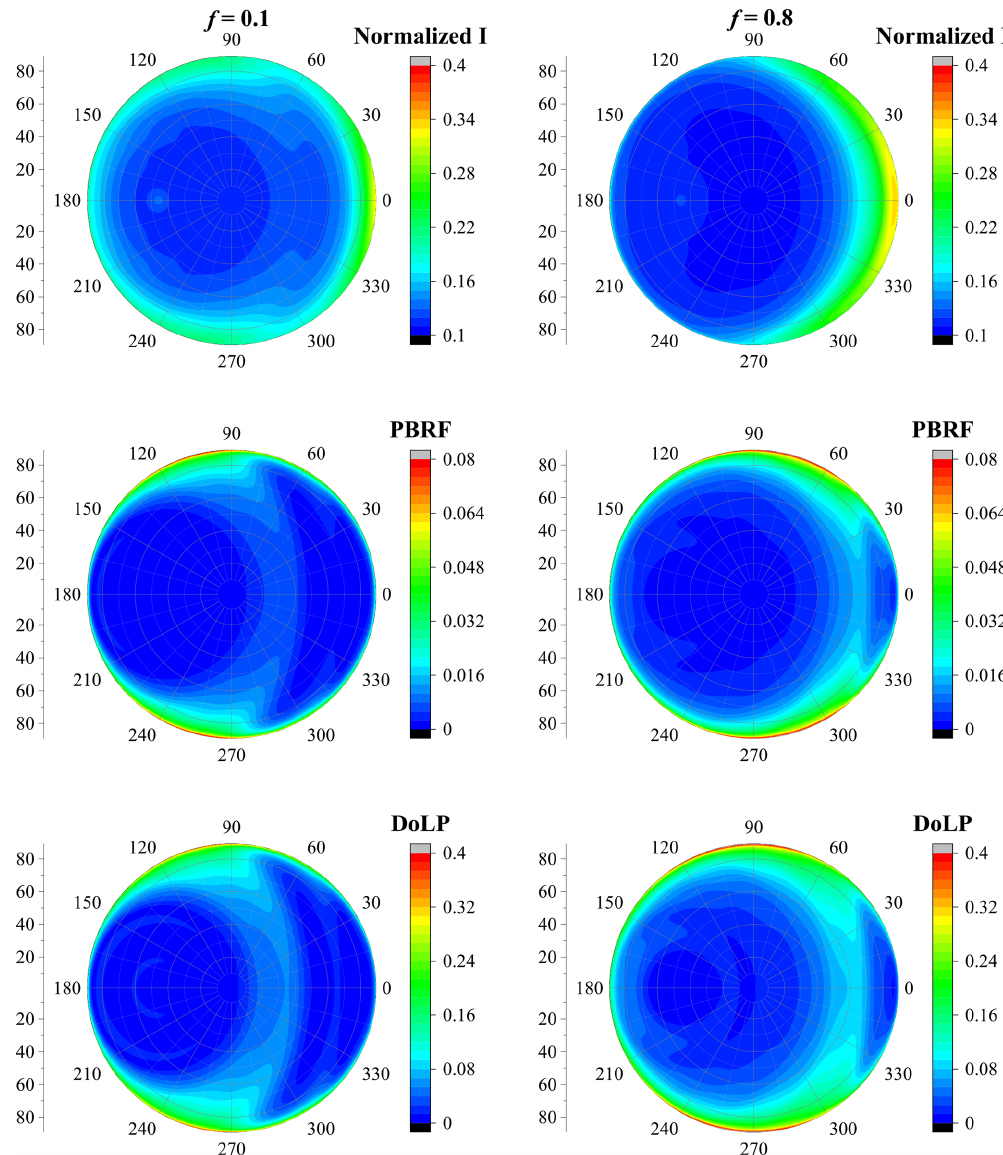
Figure 11. Similar to Fig. 9 but for d p = 2 .